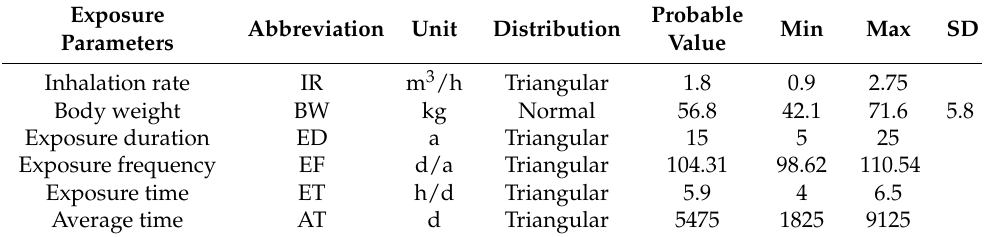
Table 3. Chinese residents (adults) exposure parameter characteristic.